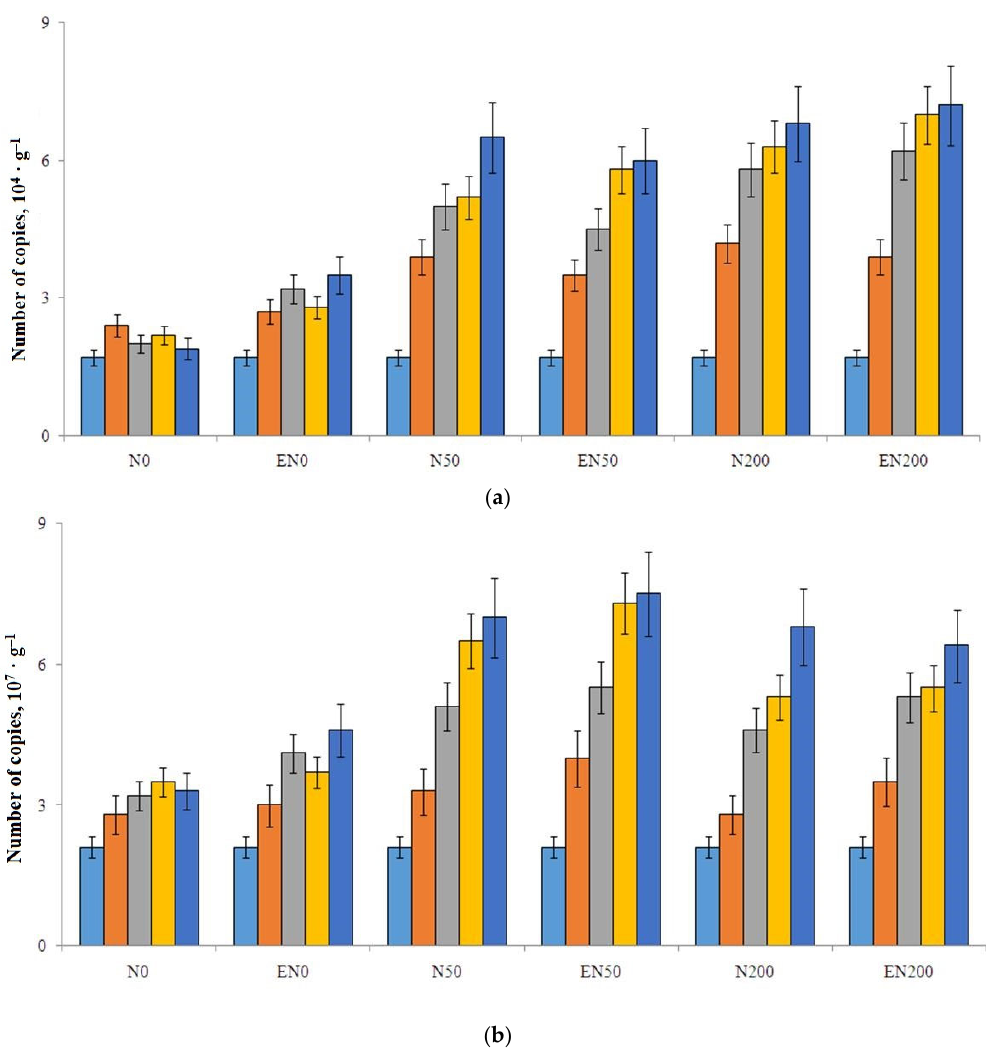
Figure 6. Dynamics of nirS ( a ) and nirK ( b ) gene copies number in soil.